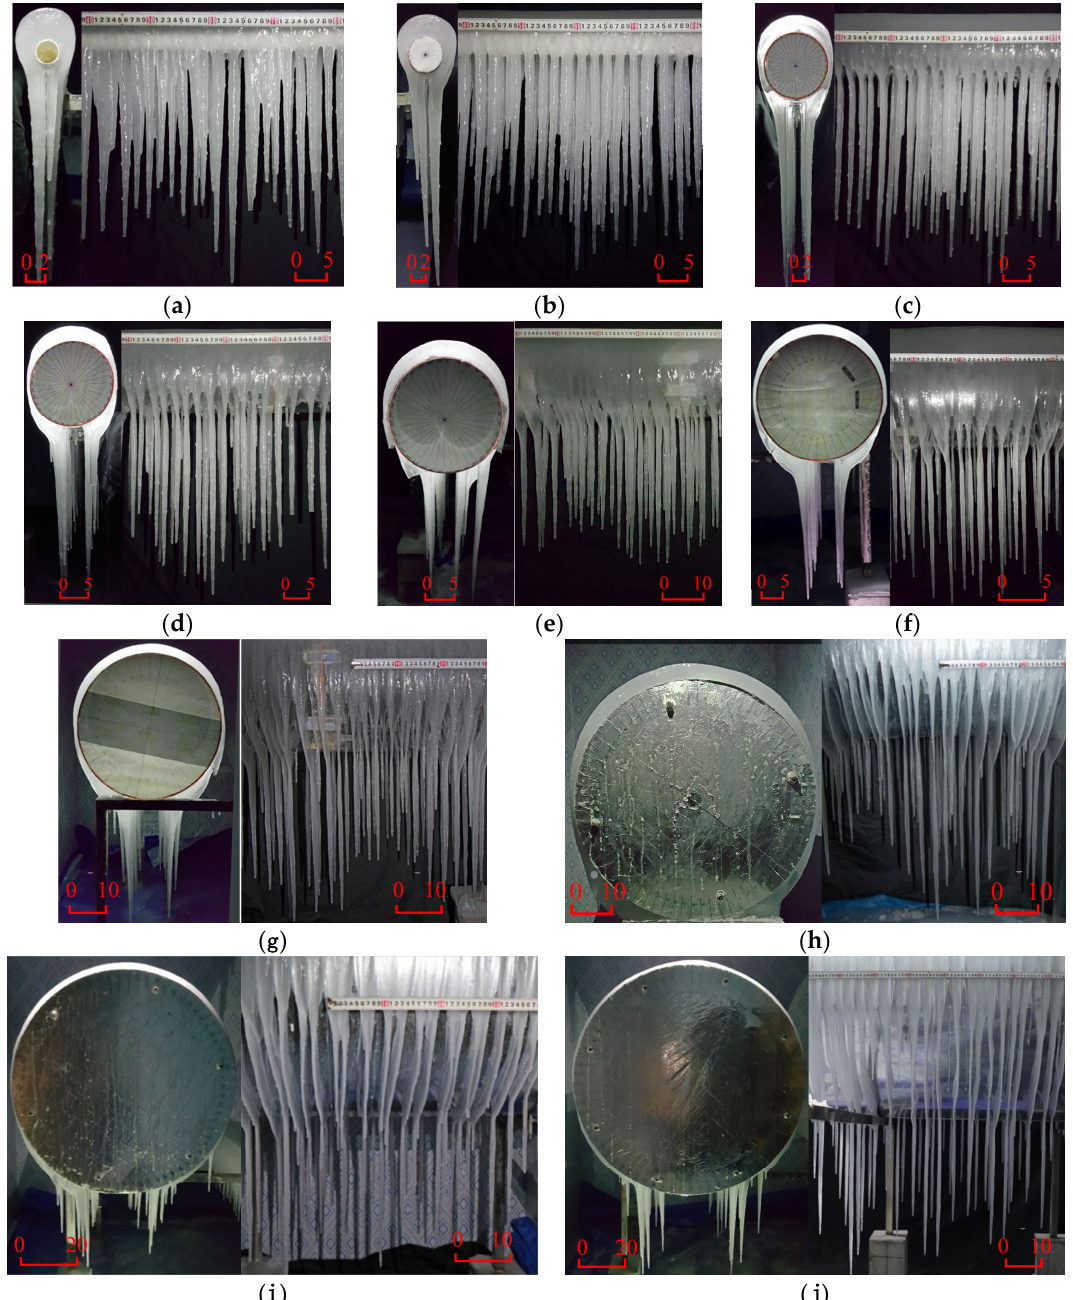
Figure 5. Profiles and side views of ice accretion on pipelines ( N = 160): ( a ) D = 25 mm, ( b ) D = 50 mm, ( c ) D = 100 mm, ( d ) D = 150 mm, ( e ) D = 200 mm, ( f ) D = 300 mm, ( g ) D = 400 mm, ( h ) D = 600 mm, ( i ) D = 800 mm, and ( j ) D = 1000 mm.